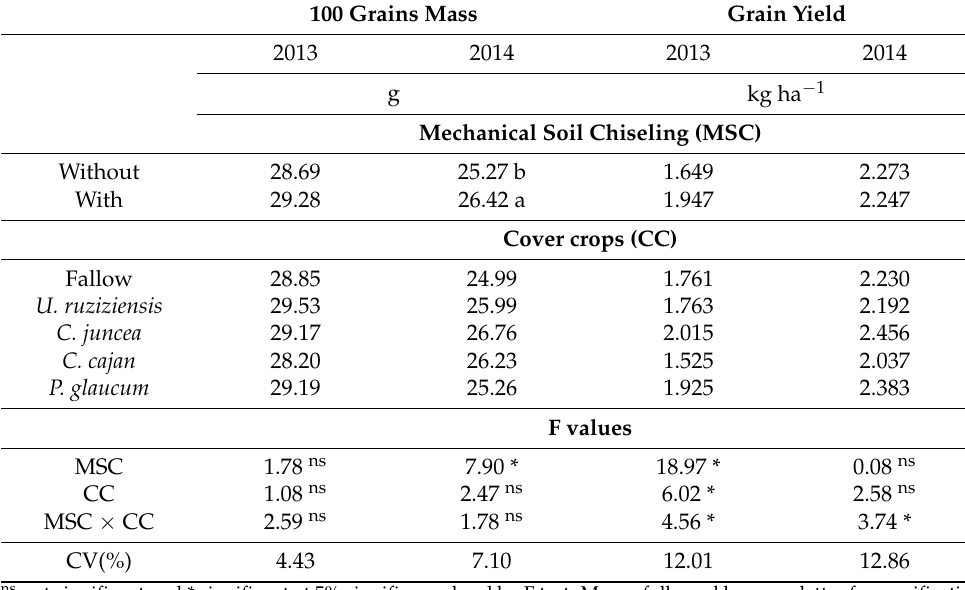
Table 4. Mean values of 100 grains mass and grain yield of “winter” common beans after mechanical decompaction and predecessor cover crops in 2013 and